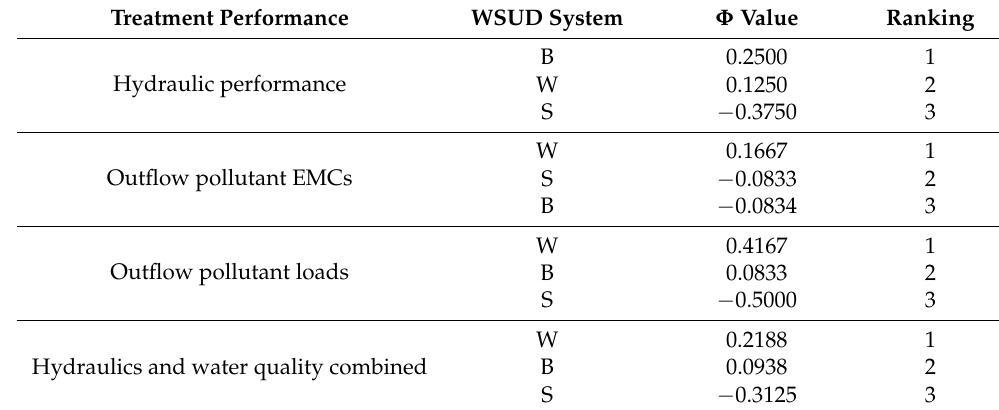
Table 1. Ranking results. B = bioretention basin; W = constructed wetland; S = roadside